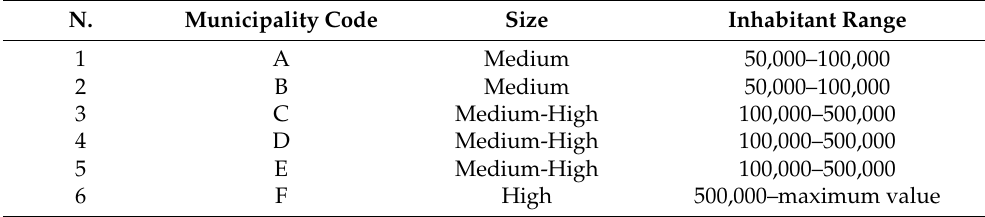
Table 2. Sample of the Italian municipalities involved.